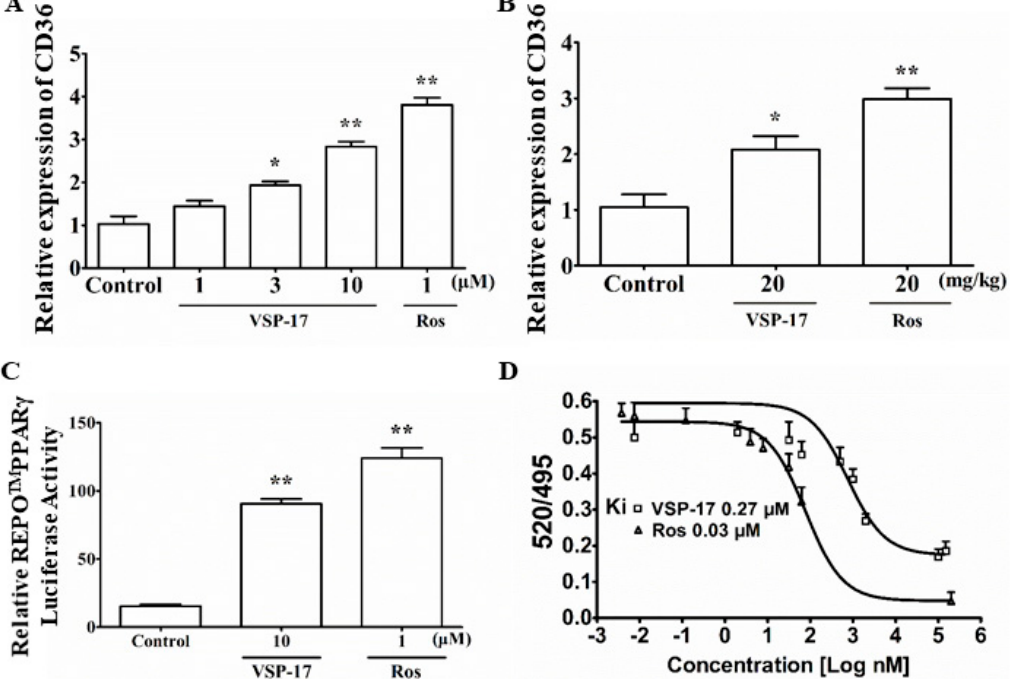
Figure 4. Effect of VSP-17 on the activation of PPAR γ . ( A ) Effect of VSP-17 on the expression of CD36 in MDA-MB-231 cells. The cells were treated with VSP-17 (1, 3, 10 μ M) and rosiglitazone (1 μ M) for 24 h. The mRNA expression of CD36 was detected using Q-PCR analysis; ( B ) Effect of VSP-17 on the expression of CD36 in MDA-MB-231 xenograft model. Mice were injected with MDA-MB-231 cells at the left and right mammary fat pads and then treated with VSP-17 (20 mg/kg) and rosiglitazone (20 mg/kg) for five weeks. Tumor samples from the breasts of mice were collected at the end of five weeks and subjected to Q-PCR analysis for CD36 expression; ( C ) Effect of VSP-17 on PPAR γ reporter gene activity. MDA-MB-231 cells were transiently transfected with REPO TM PPAR γ and then subjected to indicated treatments for 24 h. Cells were then harvested and assayed for luciferase activity. Rosiglitazone is an agonist of PPAR γ . GW9662 is the antagonist of PPAR γ ; ( D ) Binding of VSP-17 to PPAR γ -LBD in a competitive TR-FRET assay. Data were expressed as means ± S.E.M. of three independent experiments. * p < 0.05 vs. control, ** p < 0.01 vs.